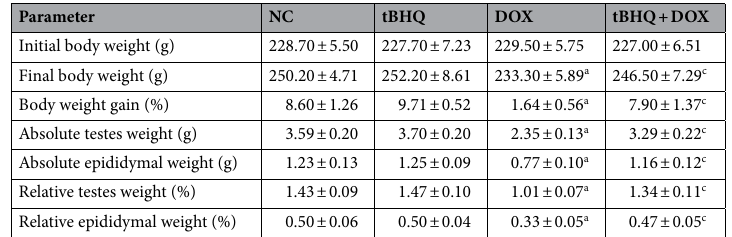
Table 1. Body weight, testicular and epididymal absolute and relative weights. Values are mean ± SD, n = 6/ group. NC: normal control, tBHQ: tert-butylhydroquinone, DOX: doxorubicin. a p < 0.05 versus NC group, c p < 0.05 versus DOX group (One-way ANOVA with Tukey’s post-hoc